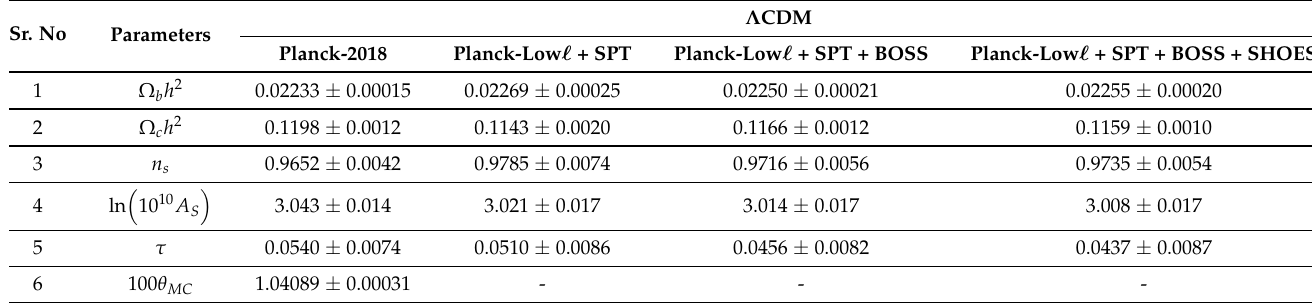
Table 1. Values of six parameters of Λ CDM from different